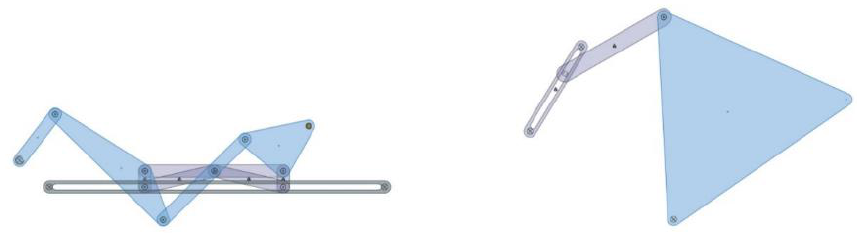
Figure 7. The structural design of the pharyngeal jaw and the oral jaw. As a result of this structural synthesis, the squeezing action of the pharyngeal jaw can be achieved by a four-bar mechanism (Figure 8a), while the translation action is possible by constructing an offset slider–crank mechanism (Figure 8b).